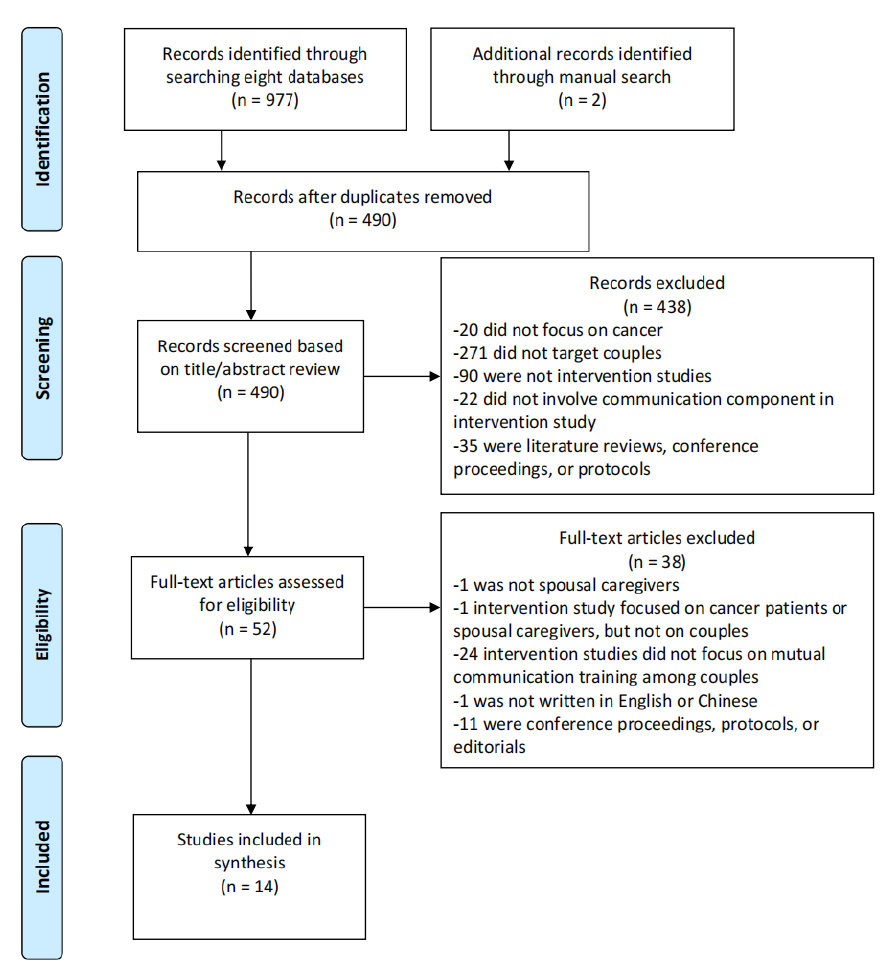
Figure 1. The flow diagram on identifying eligible articles in the literature.